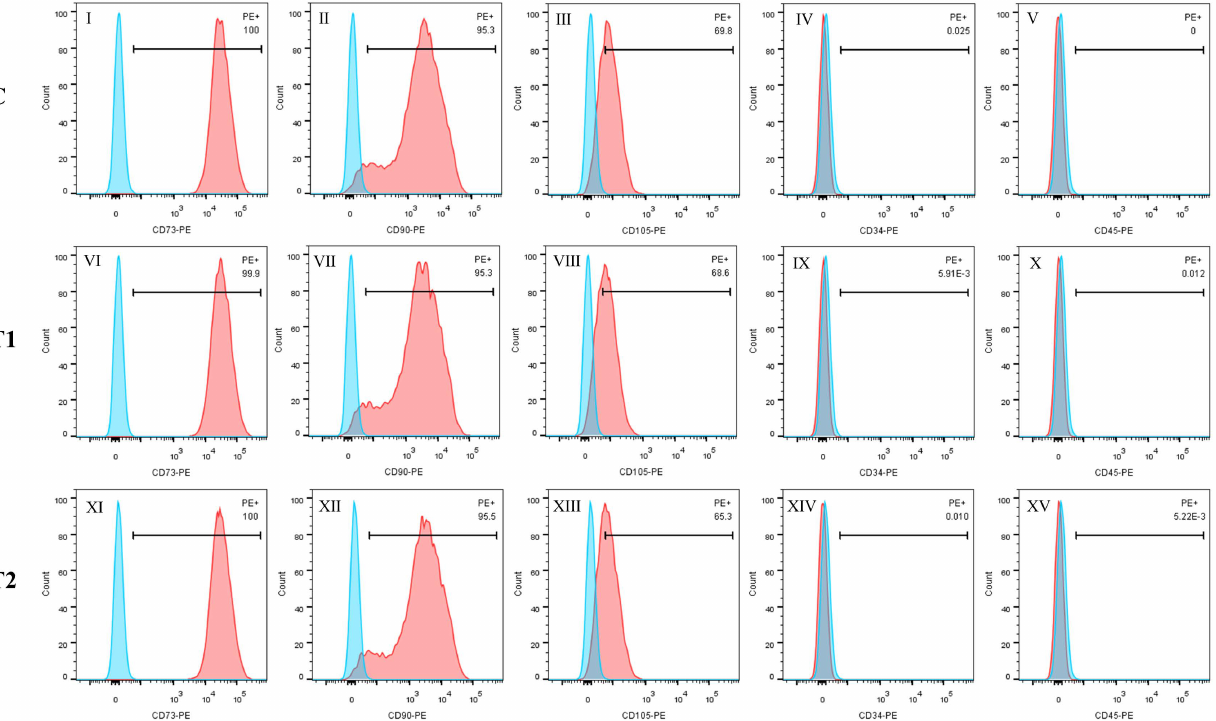
were not strongly expressed. (Figure 3).